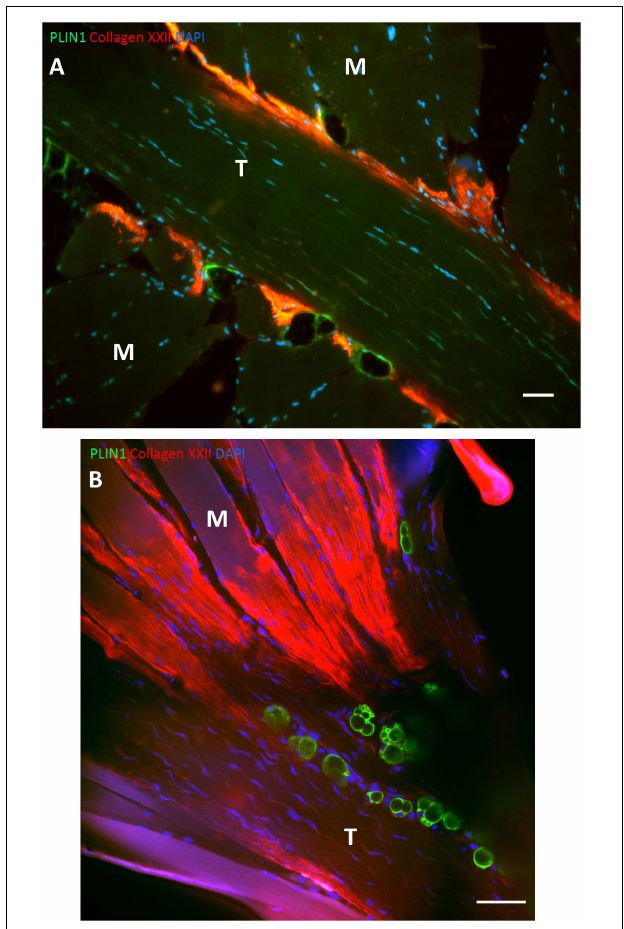
FIGURE 5 | Adipocytes at human and mouse MTJ’s. (A) The figure shows a section from human semitendinosus muscle with the tendon (T) in the middle and the muscle fibers (M) approaching from both sides. The MTJ is identified by collagen XXII immunofluorescent staining (red) and the adipocytes are stained with PLIN1 (green), and nuclei are stained with DAPI (blue). Adipocytes are located very close to the MTJ. Scale bar is 50 µ m. (B) Mouse soleus MTJ in confocal microscopy showing adipocytes (PLIN = green) and collagen XXII indicating the MTJ (red). Scale bar is 50 µ m. Images are reprinted with permission from Jakobsen et al.